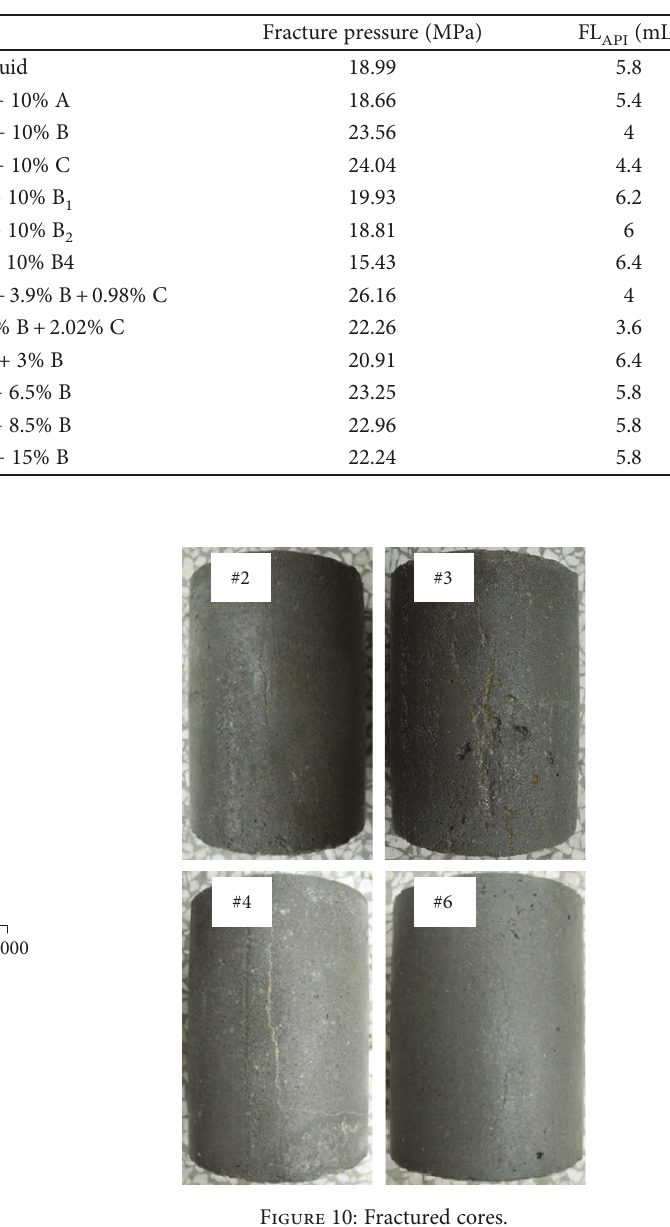
Table 6: Results of the core fracturing experiment with di ff erent drilling fl uid formulas.